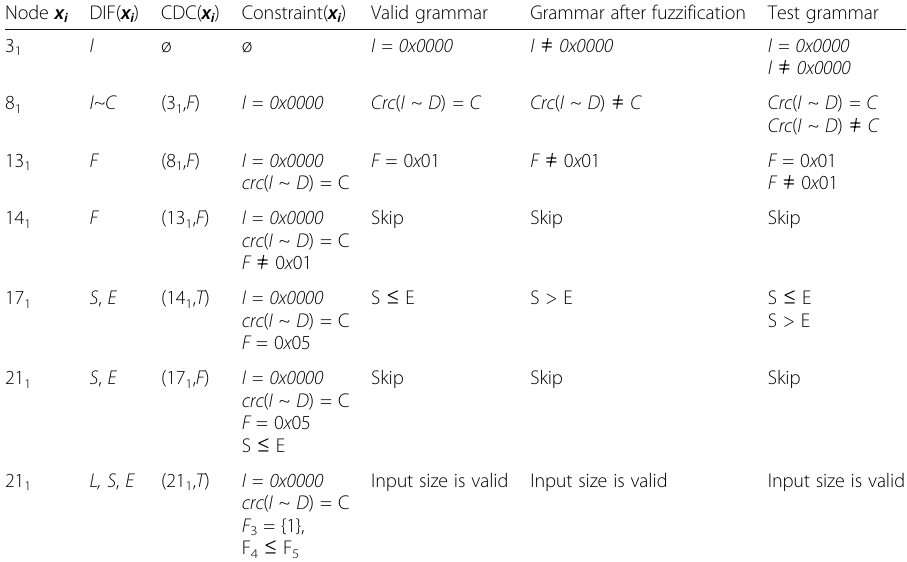
Table 1 Test case generation grammar